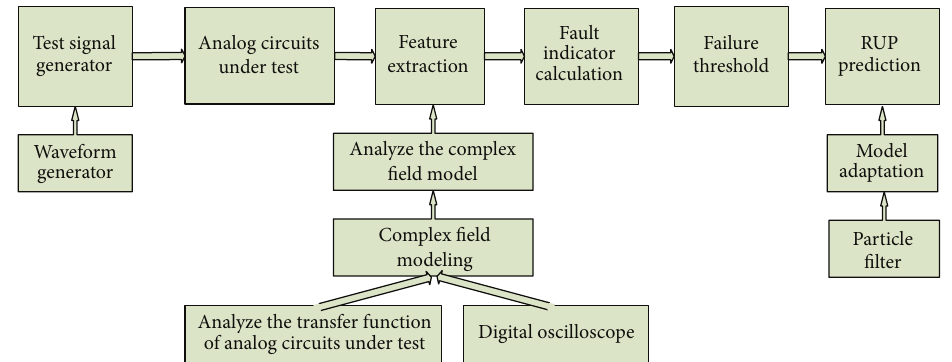
Figure 1: Framework of prediction on analog circuits proposed in this paper.